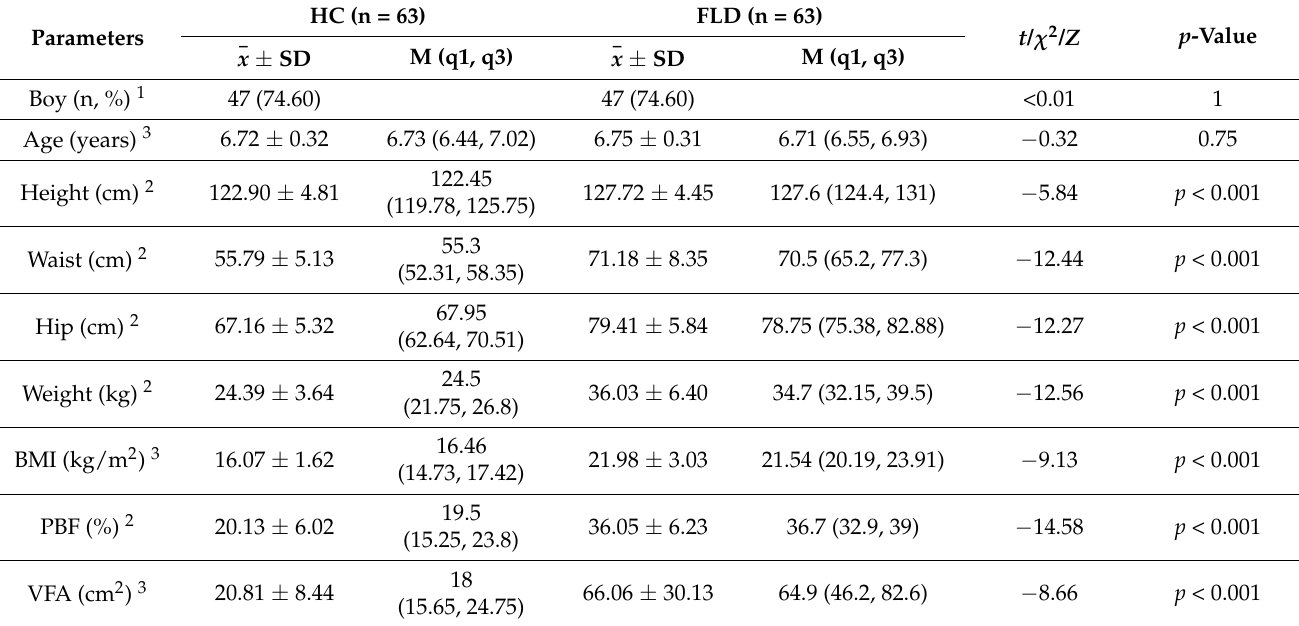
Table 1. Differences in clinical indicators of NAFLD and healthy